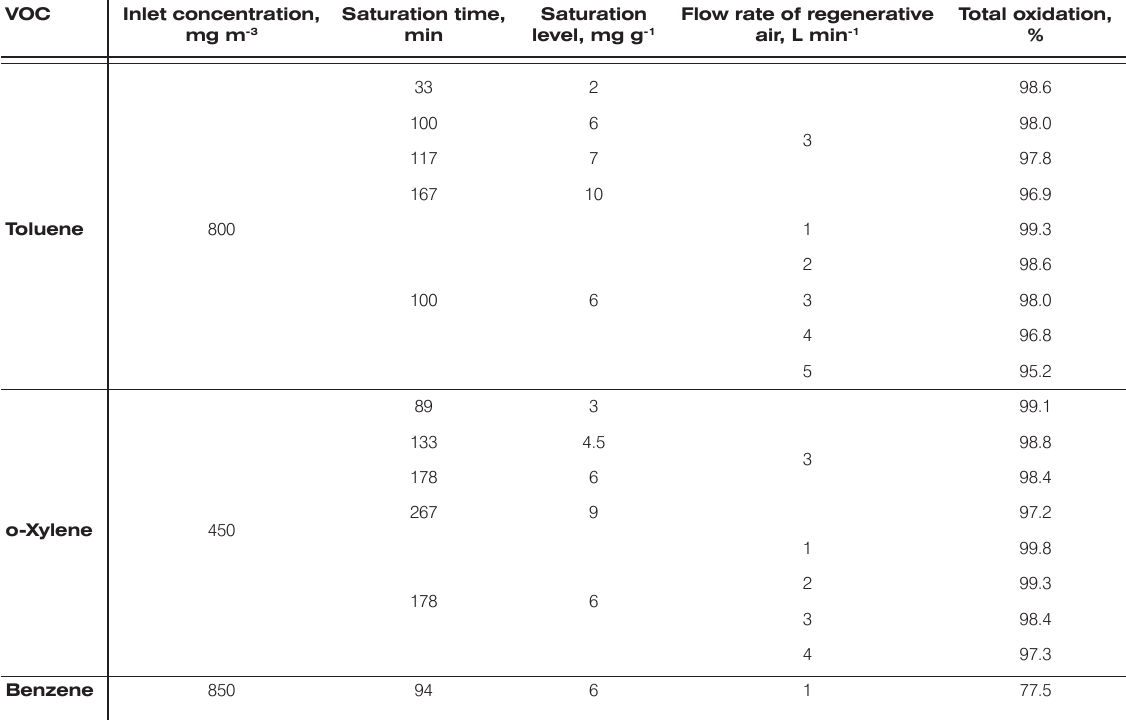
Saturation time, Saturation Flow rate of regenerative min level, mg g -1 air, L min -1 mg m -3